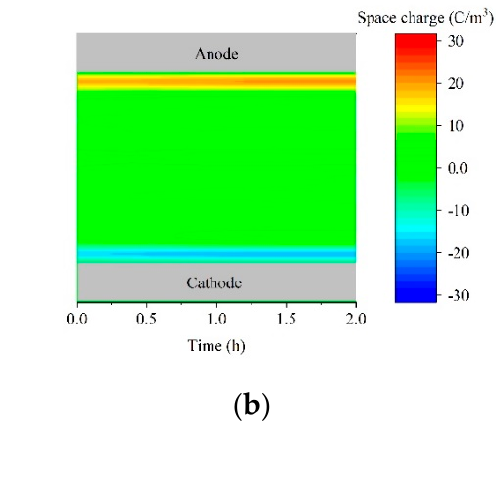
Figure 6. Current densities of pure LDPE, R-Al 2 O 3 /LDPE and A-Al 2 O 3 /LDPE depended on electrical strength.